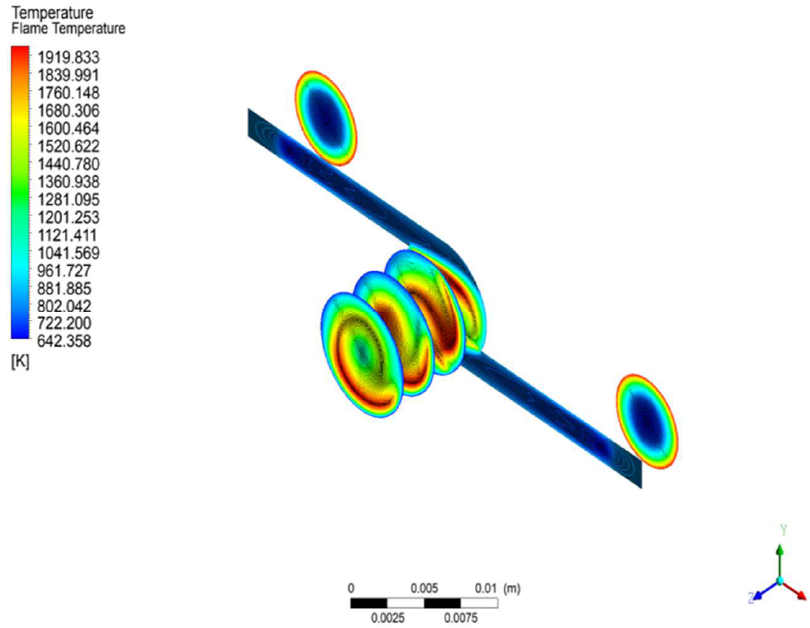
Figure 8. Temperature profile on the cross-section of z = 5, 8, 11, 14, and 17 in the vertical vortex combustor .